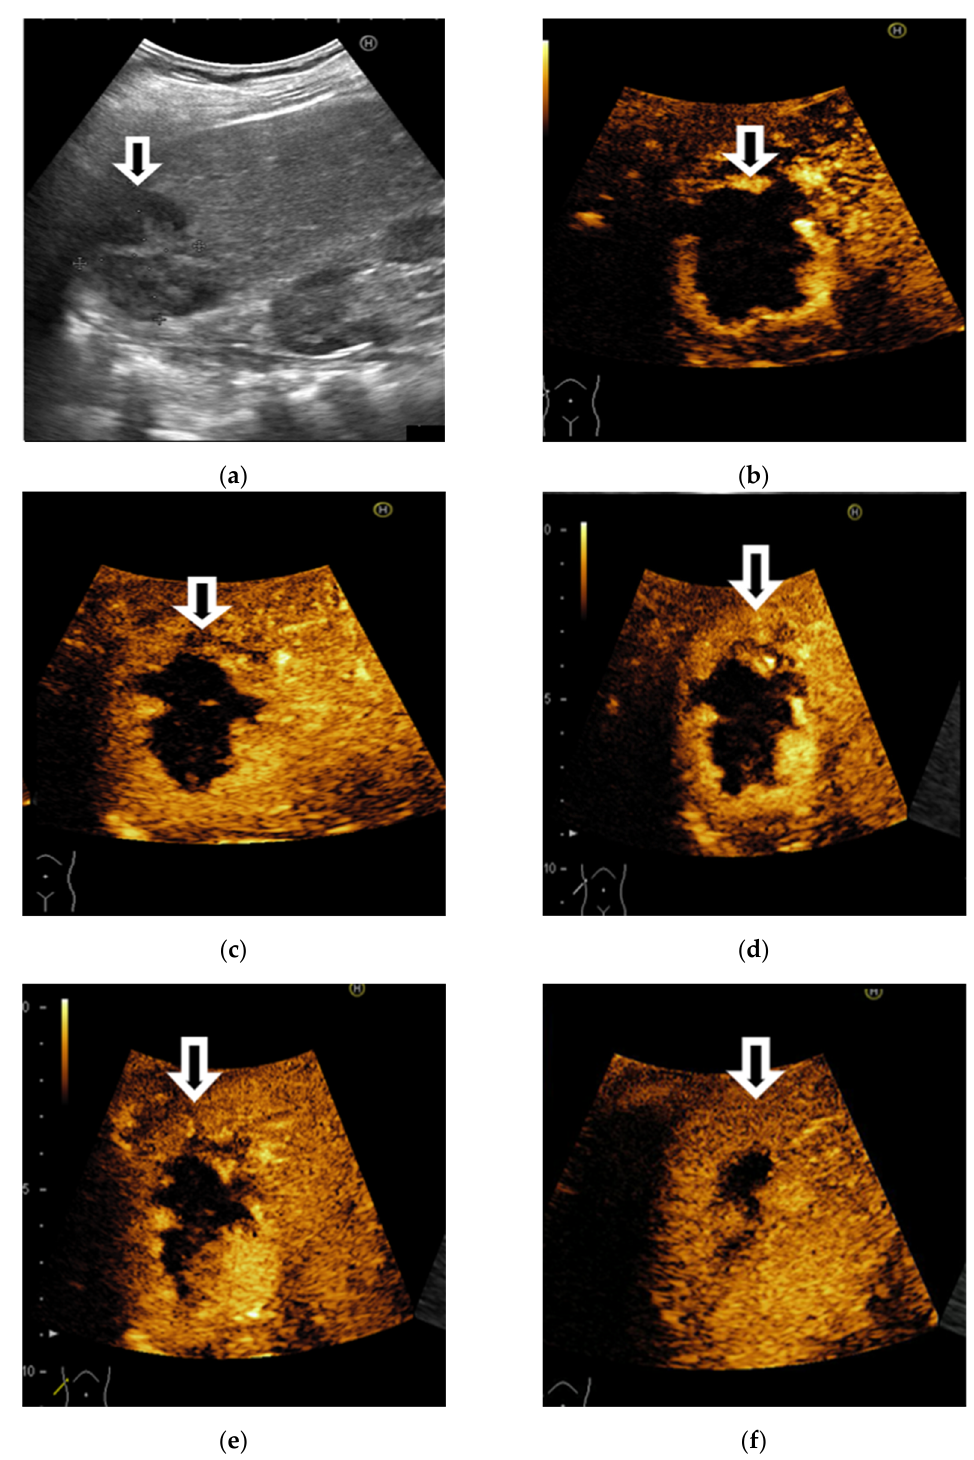
Figure 4. Illustration of LI-RADS-1 liver lesion in a patient with alcoholic liver cirrhosis. B-mode ultrasound using linear probe shows an inhomogeneous liver with nodular liver surface ( a ). In the right liver lobe, subcapsular, a well delimited, inhomogeneous hypoechoic liver lesion ( b ) that is nonenhancing on CEUS in all vascular phases ( c , d ). The final diagnosis was a complex cyst.